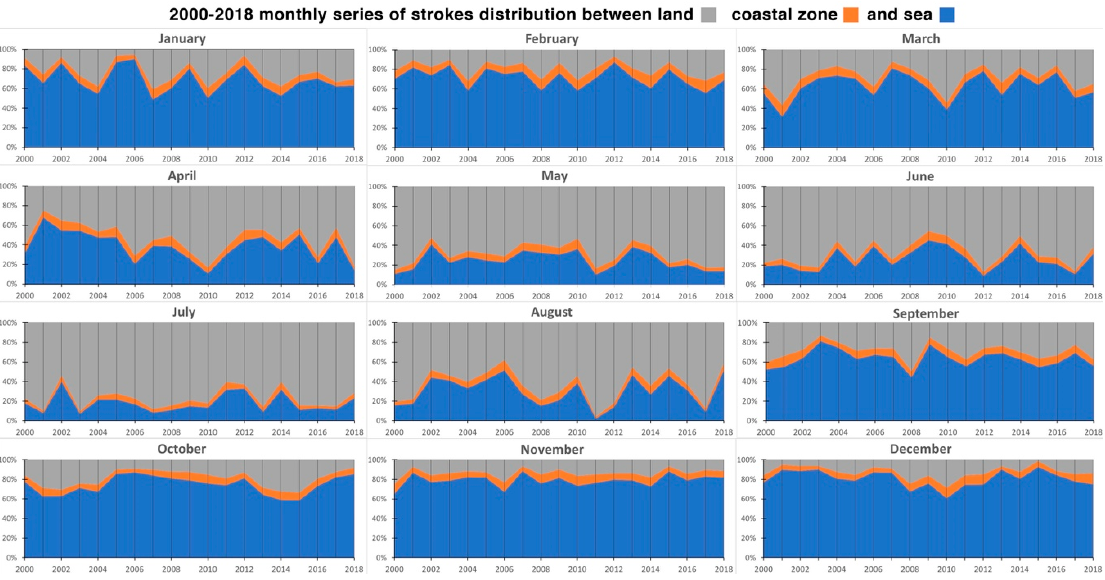
Figure 8. Monthly percentage of cloud–ground strokes between sea, land, and coastal areas (10 km depth buffer zone) for the studied period.